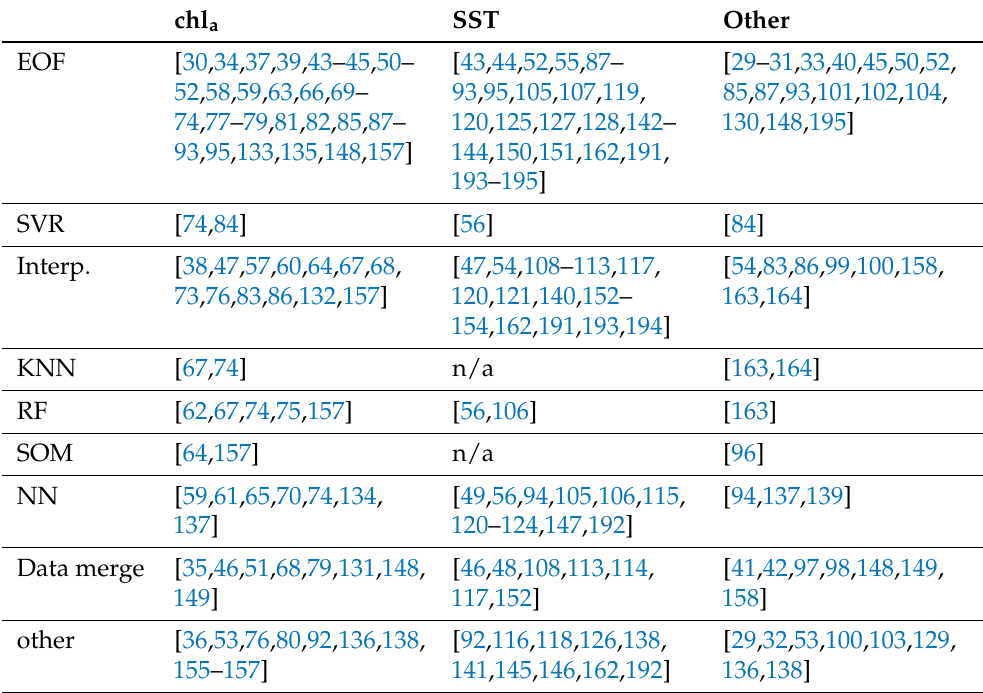
Table 2. Surveyed articles cross-referenced against the target data and utilised reconstruction